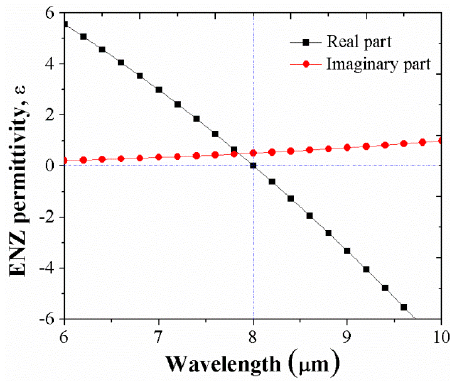
Figure 2. The dielectric constant of the ENZ material.